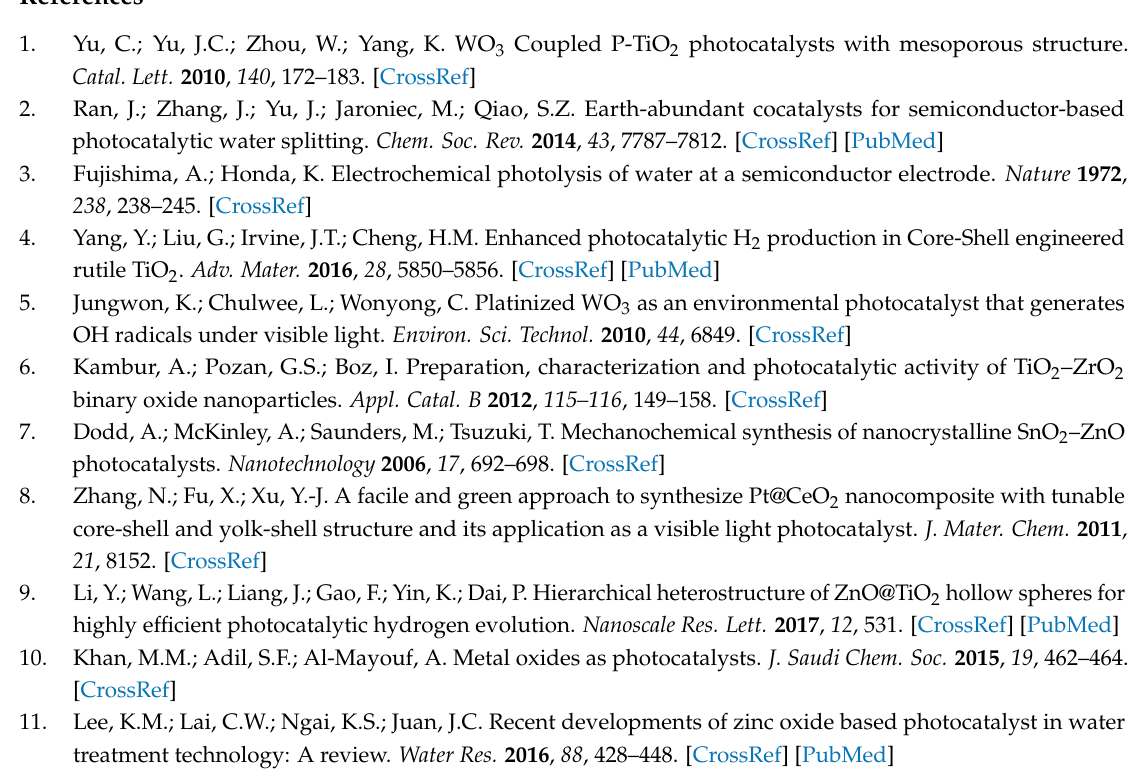
s1, Figure S1: Digital photograph of the heterostructure (A:ZRP-1, B:ZRP-5, C:ZRP-10, D:ZRP-15), Figure S2: The photocatalytic H2 production of red P, ZnO, and mechanical mixture (the content of red P is 5%), Figure S3: (a) The recycling H2 evolution reaction of ZRP-5 heterojunction. (b)The compared XPS pattern of ZRP-5 before and after irradiation, Figure S4: The valence band XPS of ZnO and ZRP-5, Figure S5: (a) SEM image of recycled Table S1: Specific surface area and pore volume of the